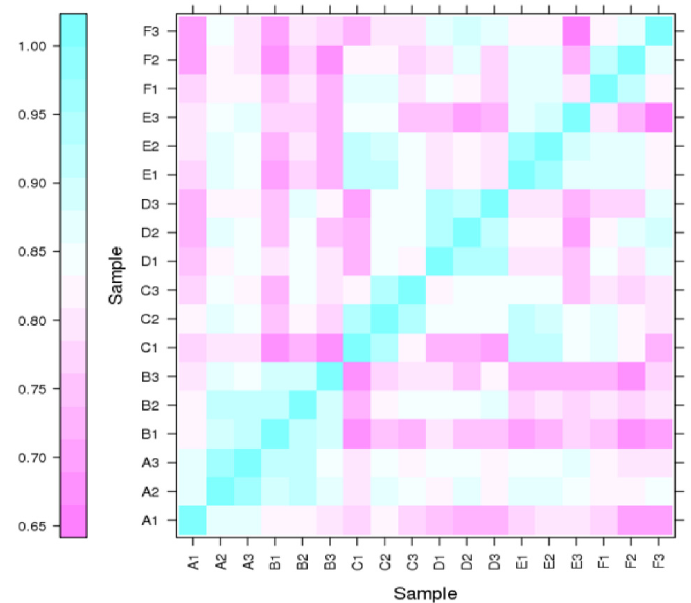
Table 2. Summary of DEGs from three comparative time points under Cd stress.